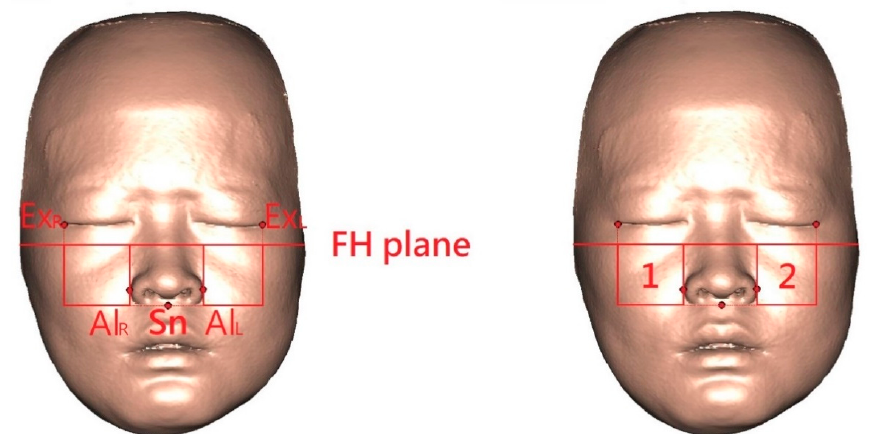
Figure 4. ( Left ) Defining the 3D regions of interest by four interconnected bone- and soft-tissue-derived reference planes. Al, Alare; Sn, subnasal; FH, Frankfort horizontal plane; Ex, Exocanthion; R, right side; L, left side. ( Right ) 3D cheek soft tissue models were constructed in the right and left anteromedial cheek regions (squares 1 and 2, respectively). Bilateral 3D cheek bone models corresponding to the soft tissue models were also constructed (see Figure 5). J. Clin. Med. 2020 , 9 , x FOR PEER REVIEW